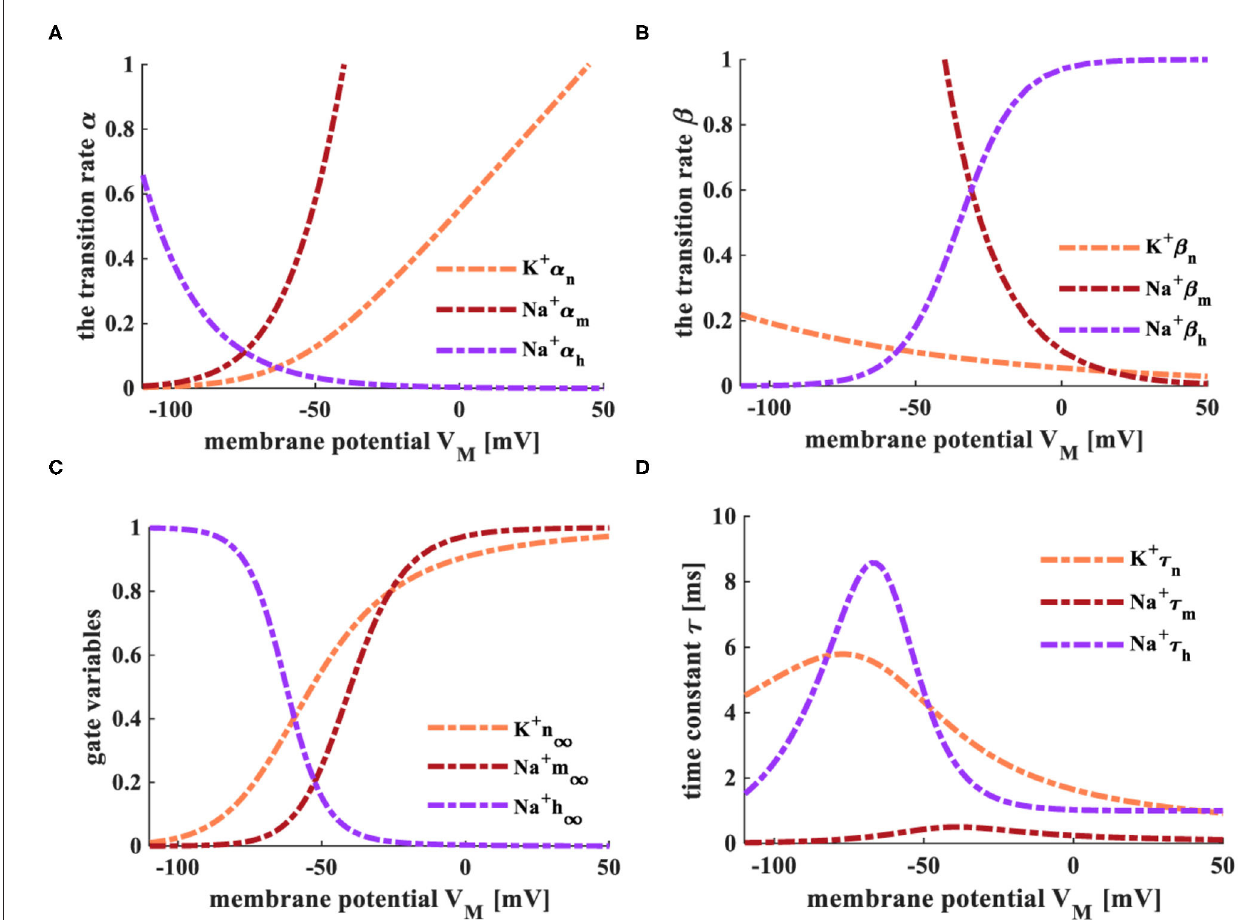
FIGURE 9 | The transition rate, gate variables, and time constant of the MHH spiking model. (A) The variation process of the transition α . (B) The variation process of the transition rate β . (C) The variation process of gate variables. (D) The variation of the time constant τ .